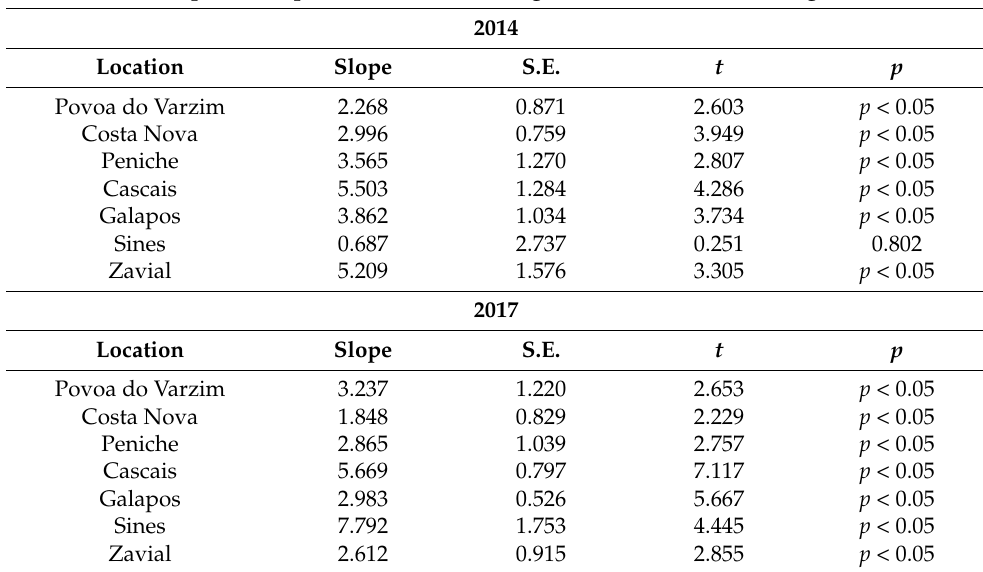
Table 4. Coefficients of ANCOVA with Separate Slopes analysis of absolute fecundity (AF, log) in different locations with size (mm, log) as covariate (d.f.: estimated degrees of freedom, SS: sum of squares, MS: mean squares).